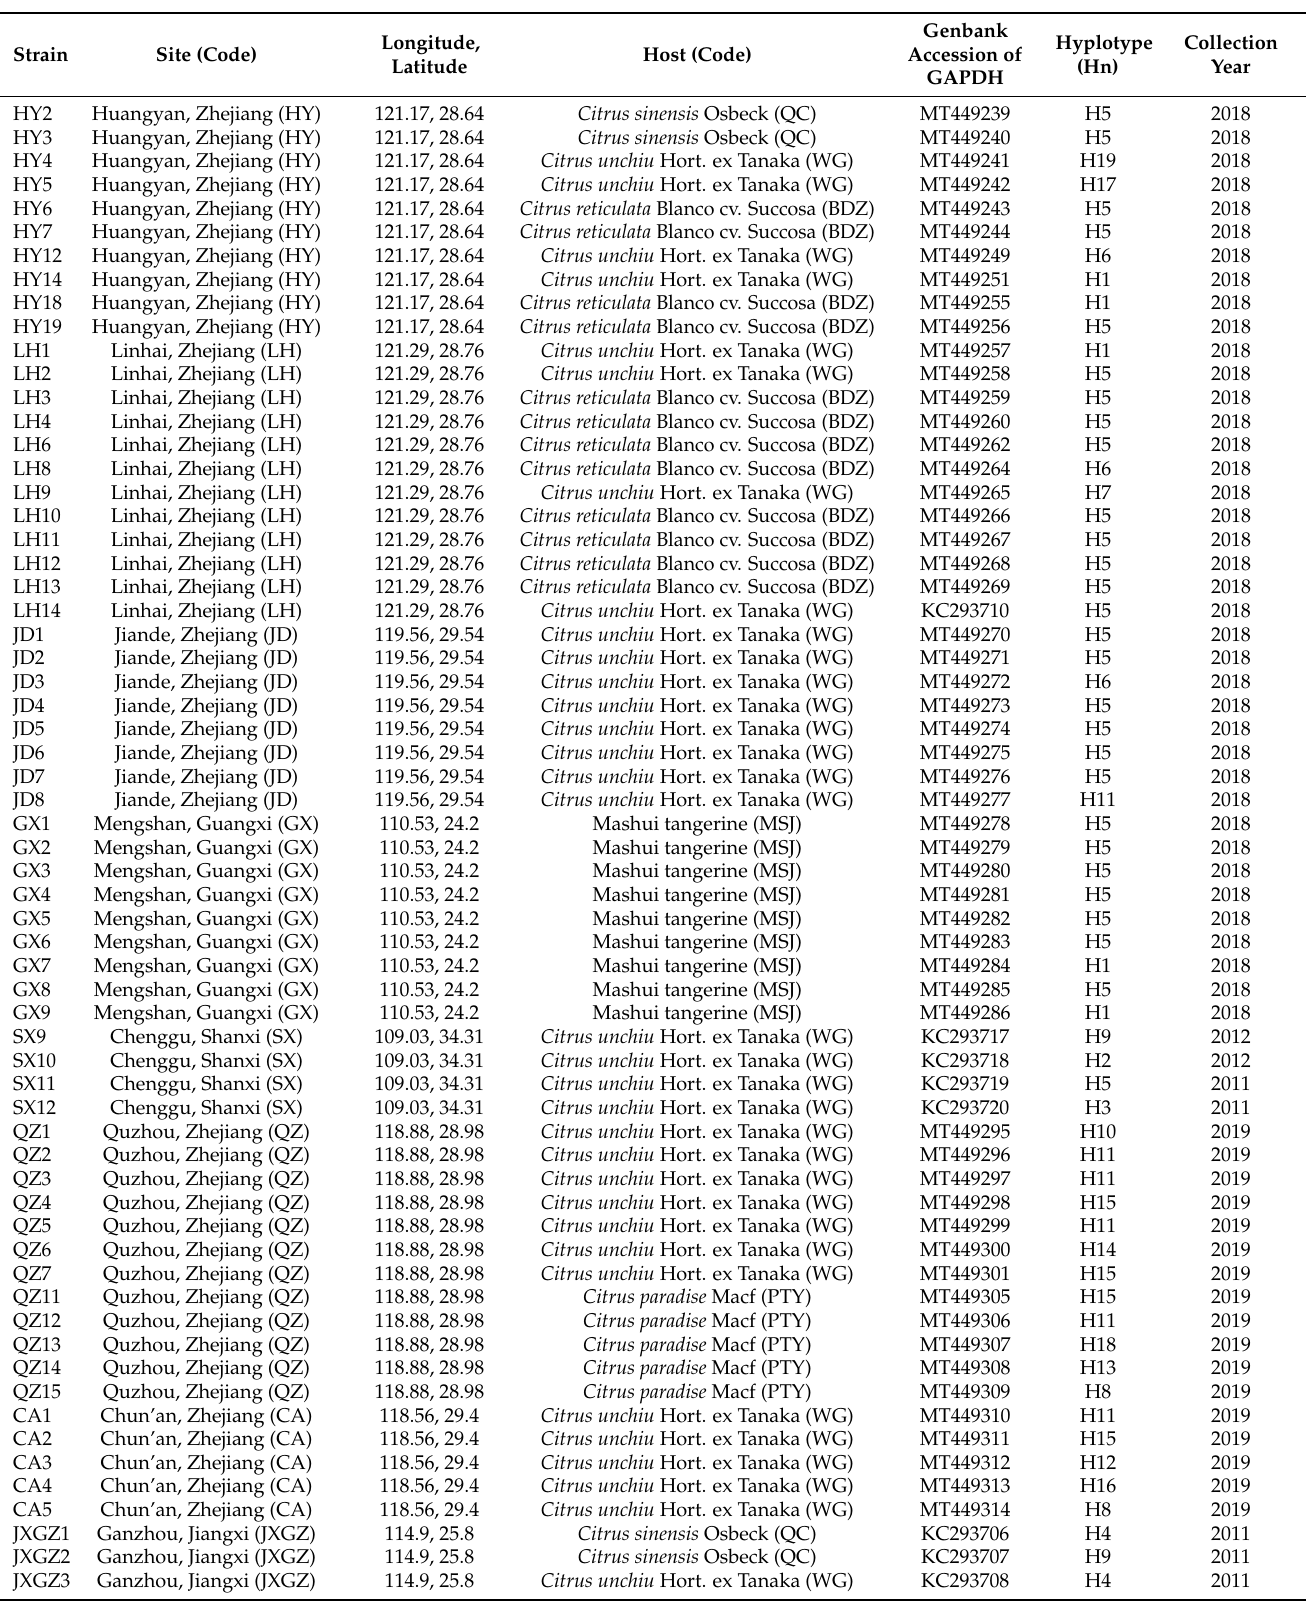
Table 1. Information of Colletotrichum gloeosporioides strains collected from citrus in